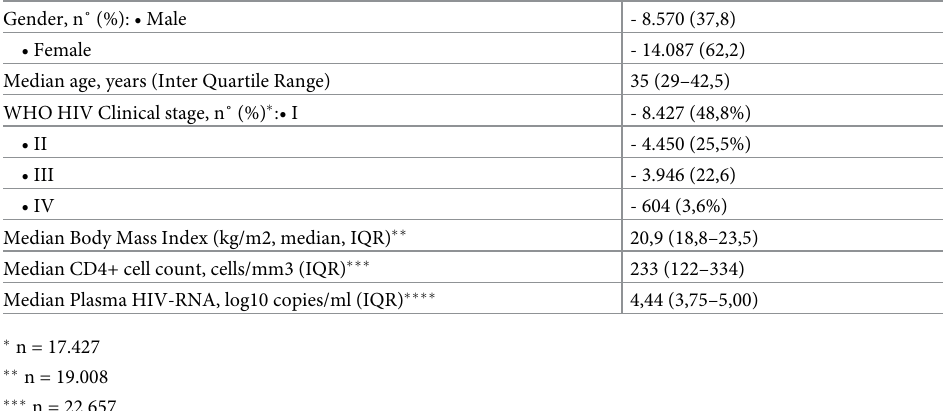
Table 1. Basic characteristics of the entire